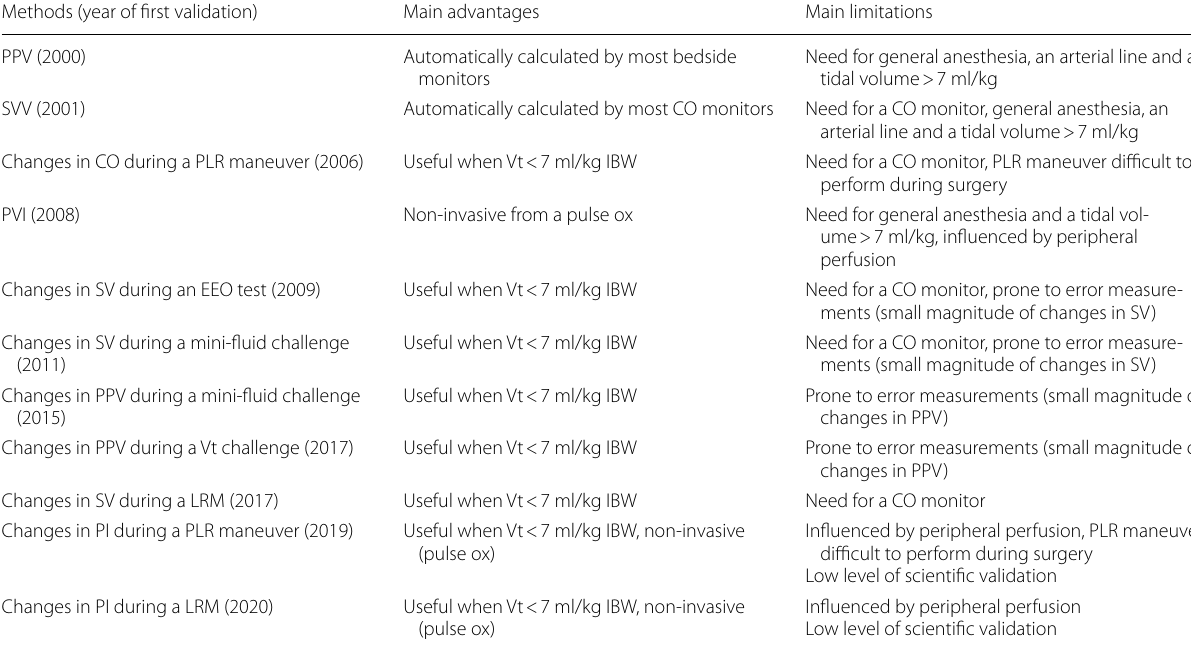
Table 1 Main advantages and limitations of dynamic indices and maneuvers developed to predict fluid responsiveness (chronologic order from top to bottom)